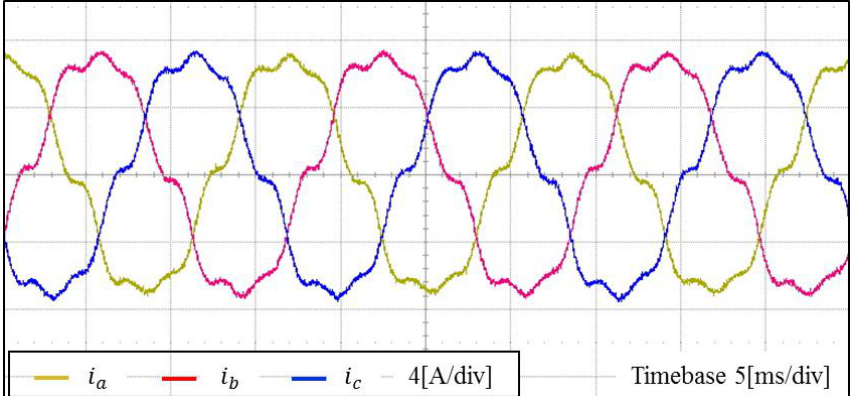
Figure 21. Experimental results for inverter output currents using the conventional PI decoupling controller and SRF-PLL under the distorted grid voltages.